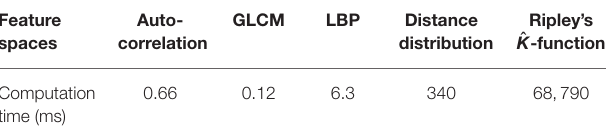
TABLE 2 | Features space computational time averaged on 100 real images. Feature